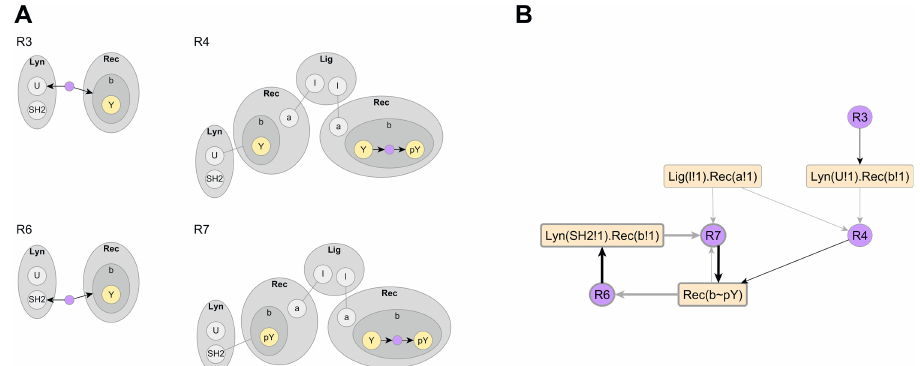
Fig 5. Visualizing Lyn-Fc ε RI interactions. (A) Lyn binds β domain of receptor that is unphosphorylated (constitutive binding–rule R3) or phosphorylated (activated binding–rule R6) via U or SH2 domains respectively. RecruitedLyn trans- phosphorylates β domain on the ligand-crosslinked receptor dimer (constitutively recruited Lyn–ruleR4, actively recruited Lyn–ruleR7). (B) The compressed atom-rule graph revealsa positive feedbackloop betweenactivated Lyn recruitment and receptor phosphorylation (highlighted with bold lines).